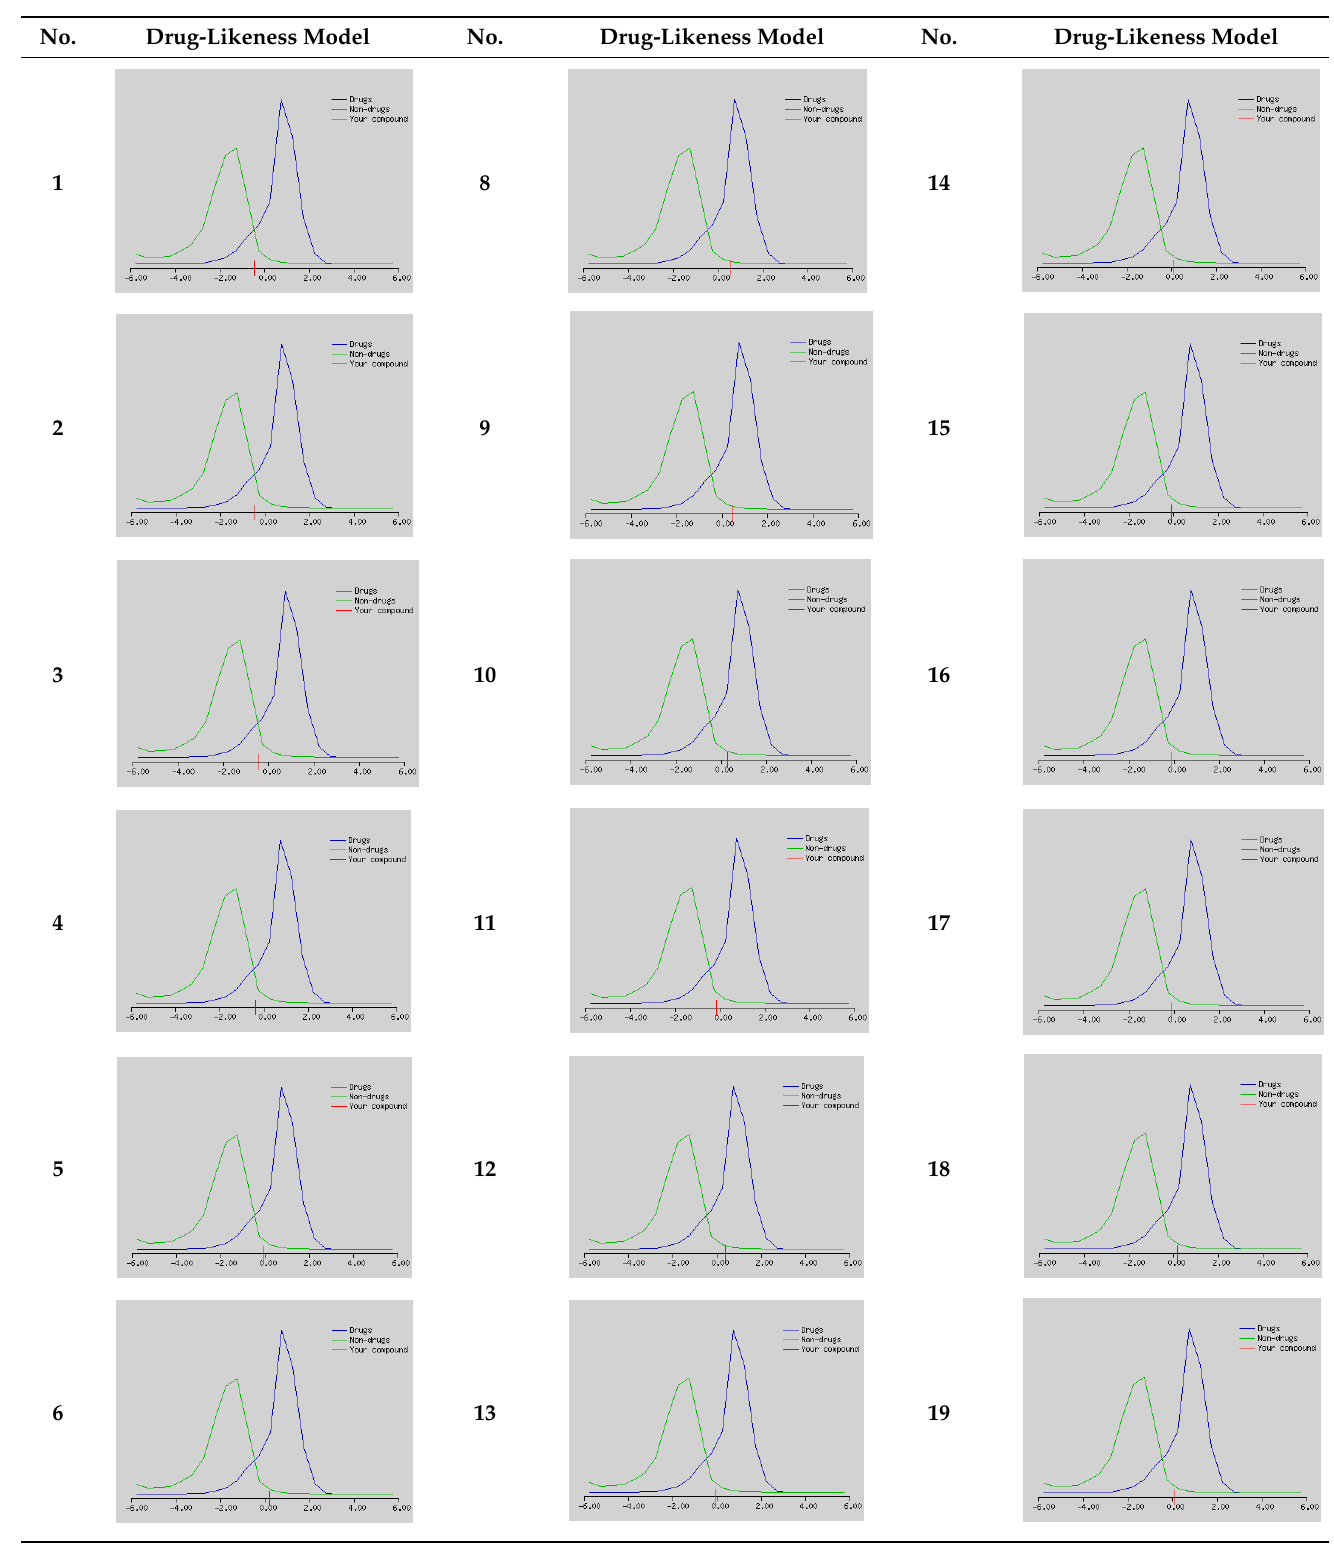
Table 8. Drug-likeness modes of tested compounds.